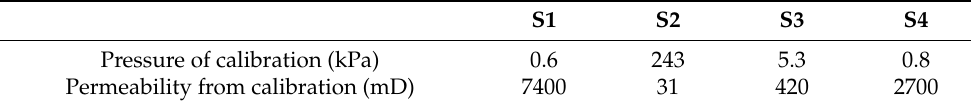
Table 2. Pressure and permeability from calibration after sample fracturing.